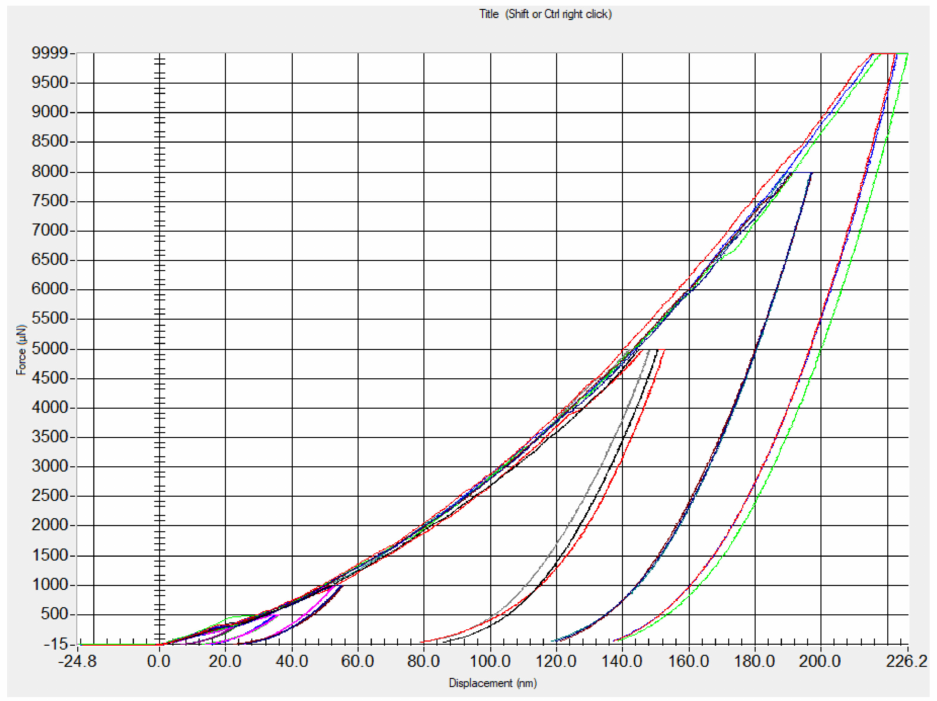
Figure 5. Loading and unloading curves under six kinds of